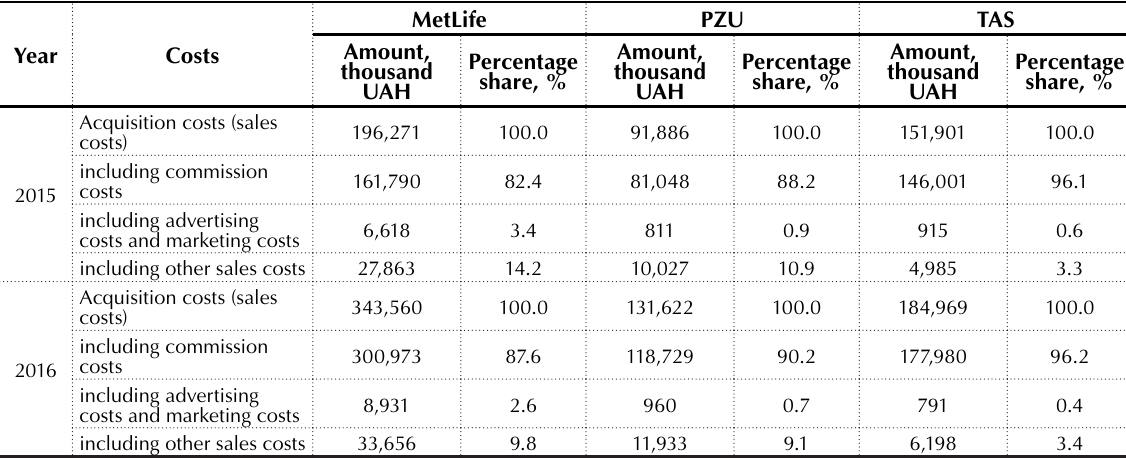
Source: Sites of the